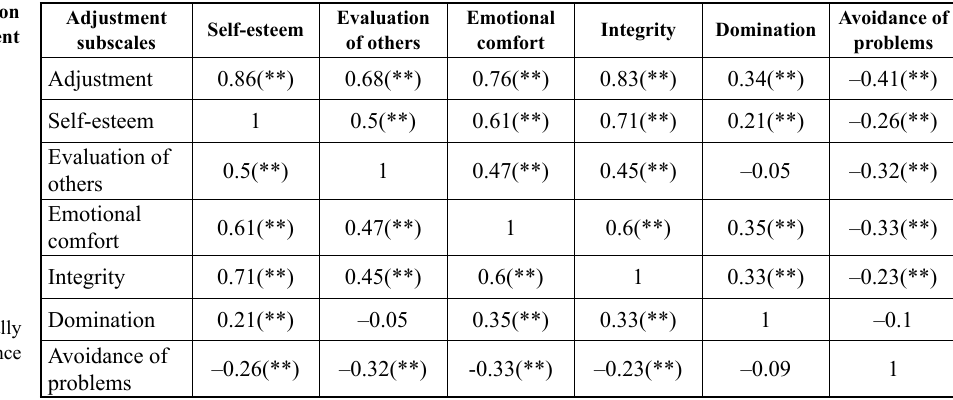
Table 1. Inter-correlation indices of adjustment scales